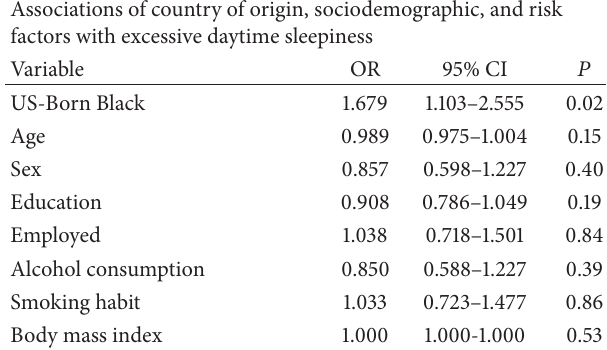
Table 2: Regression coefficients of the EDS measure on country of origin (US-Born Black versus Foreign-Born Black), sociodemo- graphic, and risk factors.